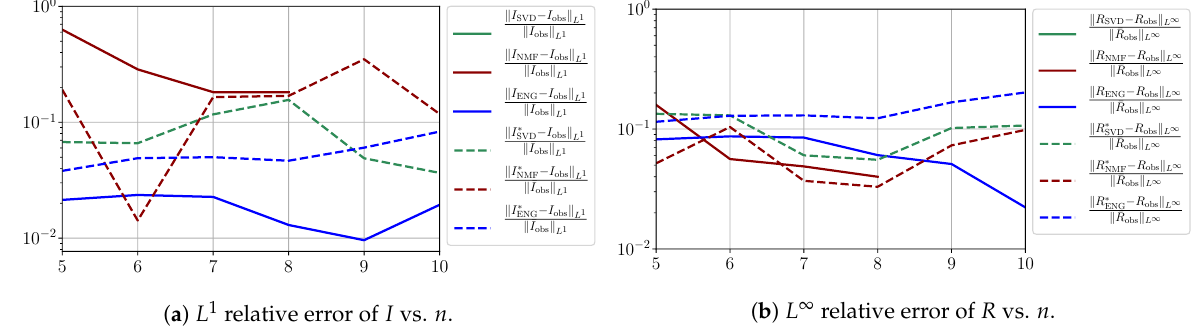
Figure A11. Forecasting errors of I and R (from T = 05/04).